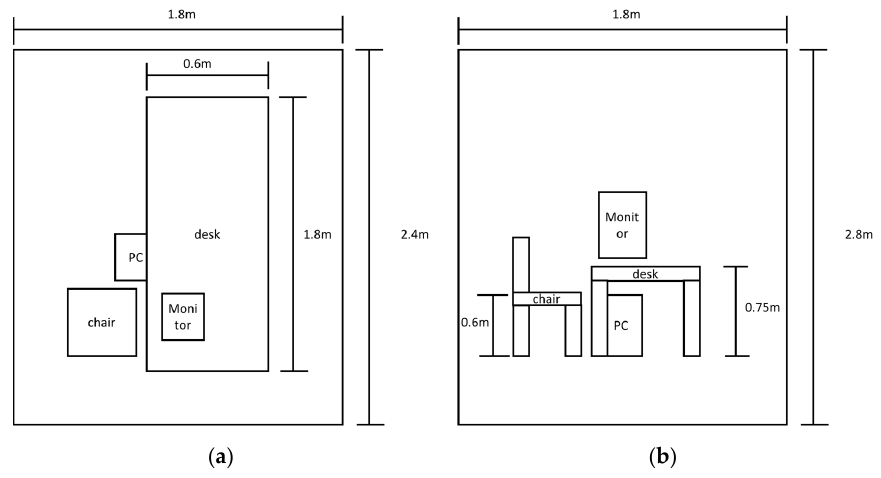
Figure 1. Office experimental environment ( a ) plan; ( b ) cutaway view.